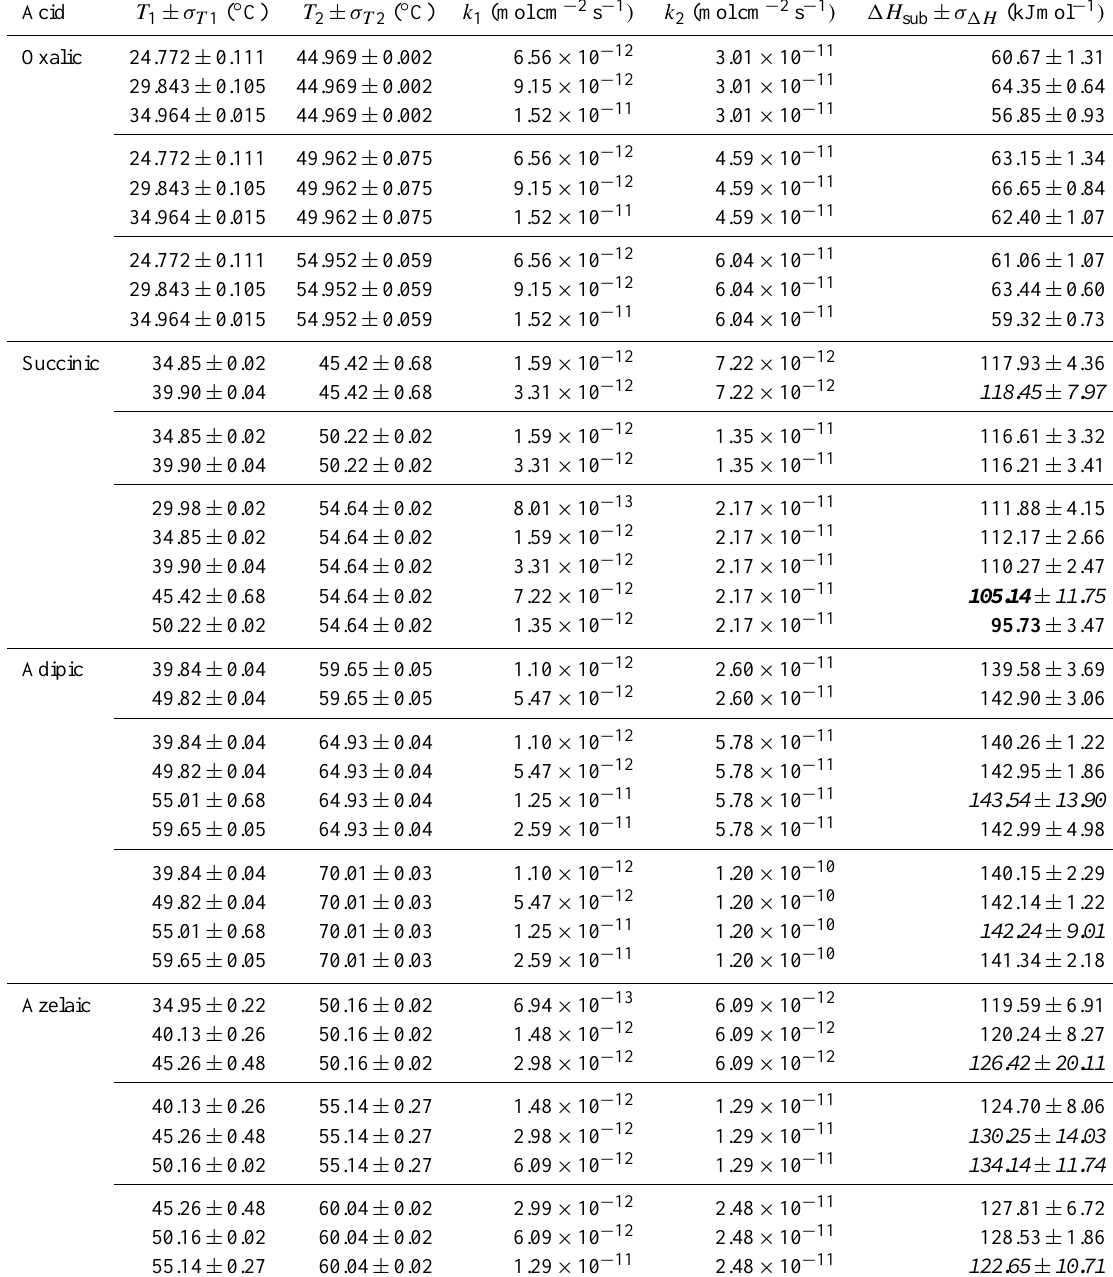
Table 3. Enthalpy of sublimation calculated from acid deposition rates measured in our experiment. Considering the succinic acid (bold highlighted values), when T 2 approaches T L , the calculated enthalpy deviates from the values in previous works, whereas the temperature oscillations larger than ± 0.5 ◦ C produce an error ≥ 8kJmol − 1 on the enthalpy of sublimation (italic values). Oxalic and succinic acids (weak lattice energies at low temperature) sublimate at smaller temperatures, in the range 25 / 30–55 ◦ C where the sublimation process was monitored. Otherwise, adipic and azelaic acid sublimate at larger temperatures. The temperature range is wide enough to calculate the enthalpy of sublimation but should be extended if the intent is to monitor the complete sublimation process (in particular for adipic acid, T ≥ 75 ◦